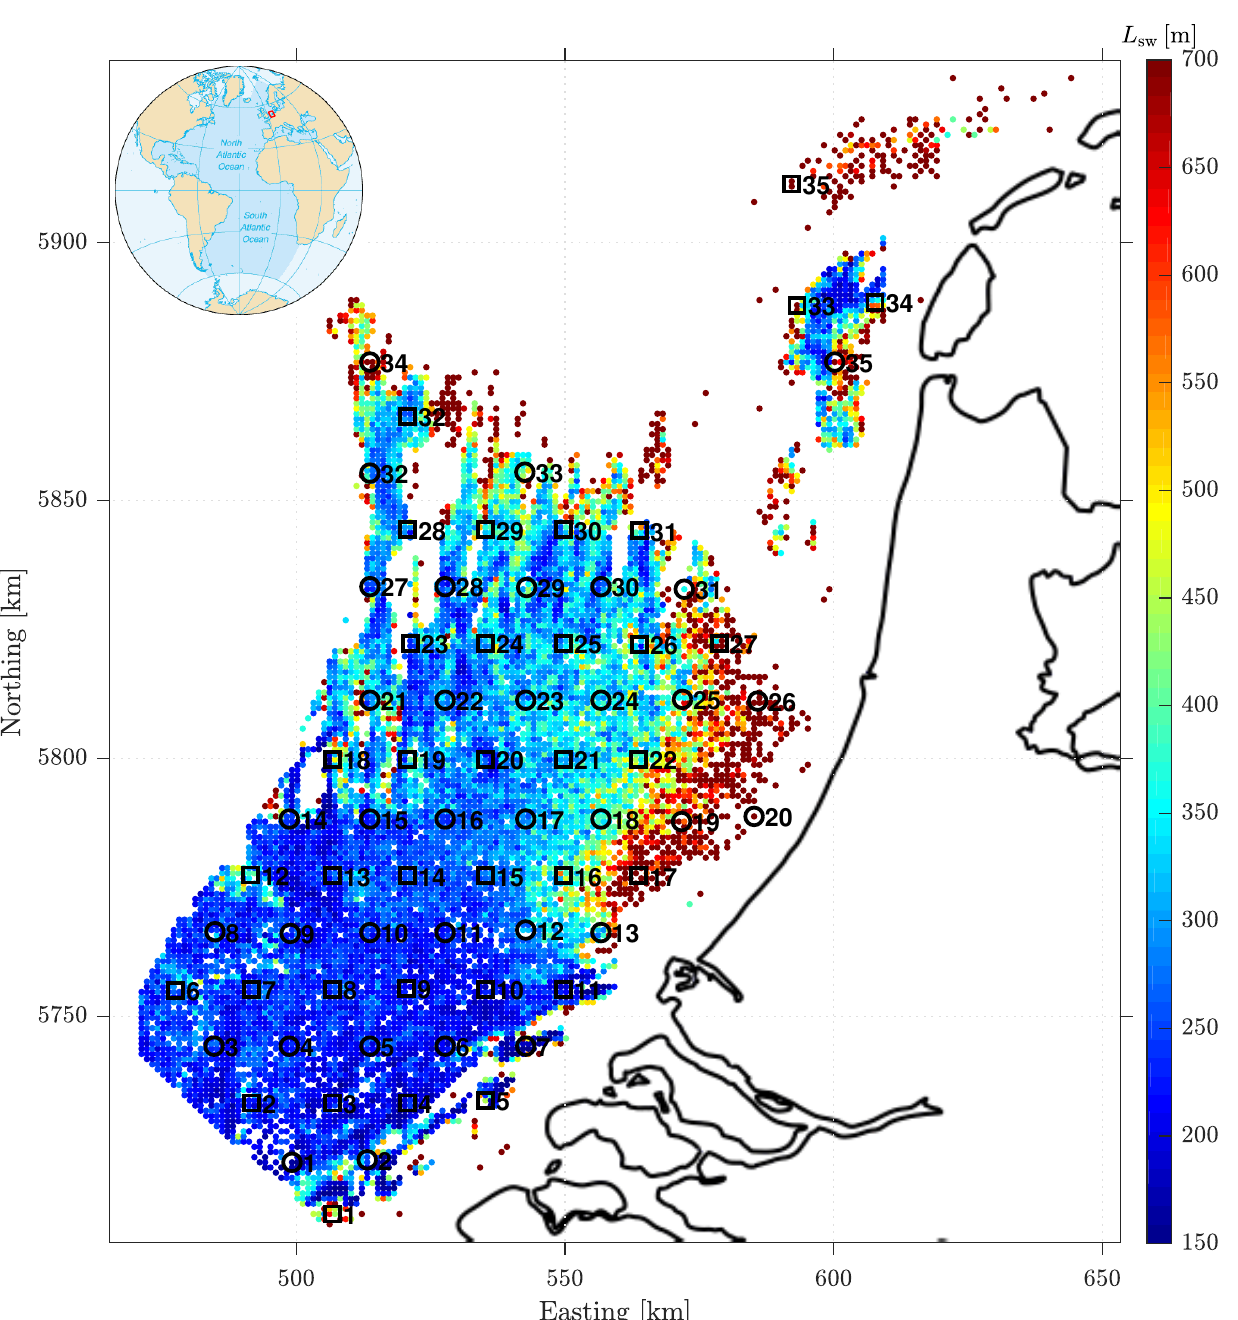
Figure 2. The calibration (circles) and validation (squares) locations determined using two staggered grids. The colored dots indicate observed sand wave lengths at locations where sand waves oc- cur [12,33]. The location of the North Sea is indicated by the red box on the shown globe (By CIA— CIA World Factbook—Atlantic Ocean (picture URL), Public Domain, accessed on 11 November 2022., https://commons.wikimedia.org/w/index.php?curid=7627352). For the surface wave height, the significant wave height from the data set [12,33] is used. The wave period is an uncertain parameter, as wind waves typically tend to have a range of wave periods. Additionally, the wave period that is relevant for the free water motion does not have to be the same wave period relevant for the water motion near the bed at tens of meters of water depth. In this model study, the wave period T w is used